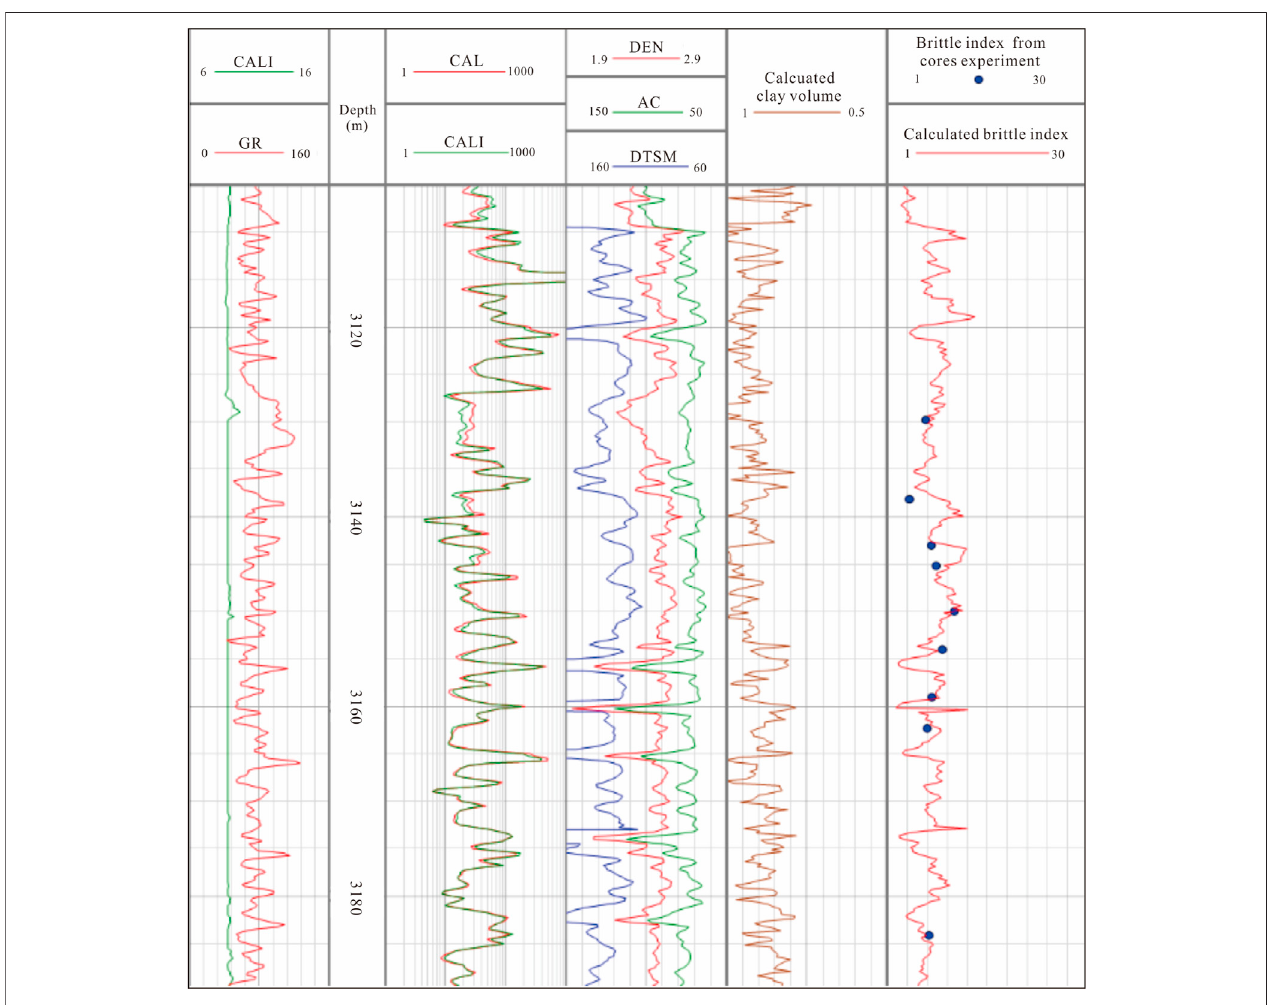
FIGURE 18 | Processing results of the brittleness index of Well Ji 174.